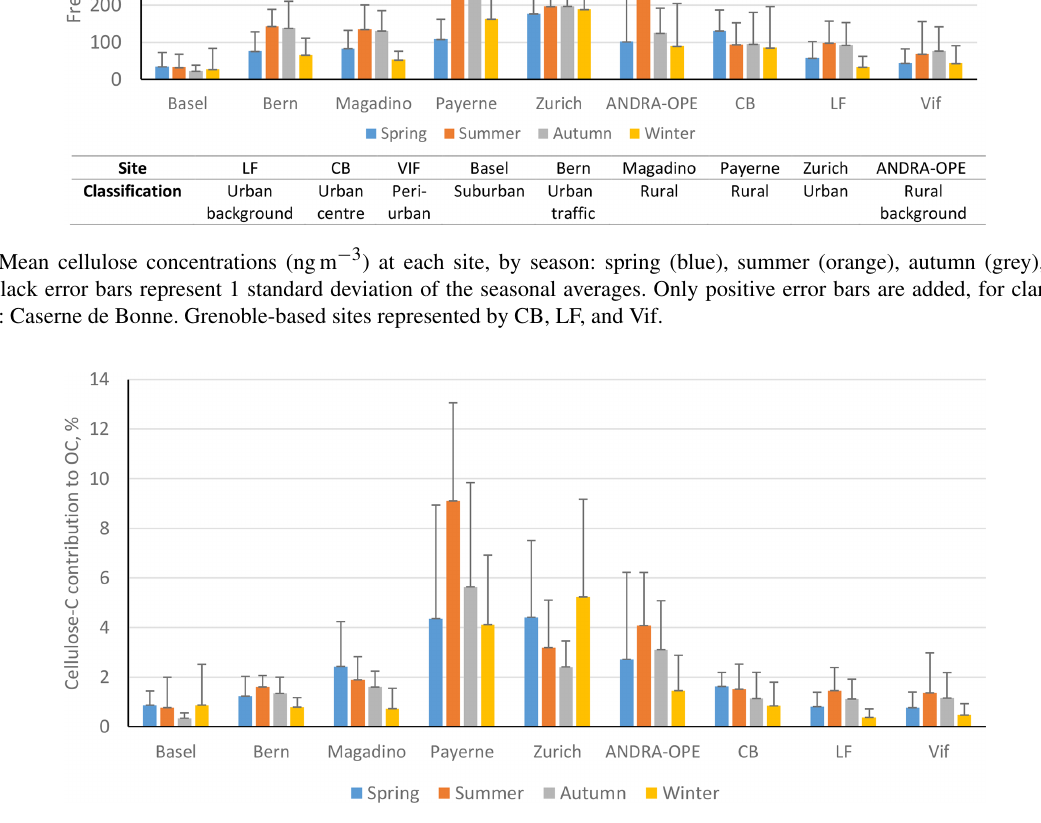
Figure 5. Seasonal contributions of cellulose C to OC (%) in PM 10 across the nine sites. Seasons are as follows: spring (blue; March– May), summer (orange; June–August), autumn (grey; September–November), and winter (yellow; December–February). Black error bars represent 1 standard deviation of the mean values. Only positive error bars are included, for clarity. LF: Les Frênes, CB: Caserne de Bonne. Grenoble-based sites represented by CB, LF, and